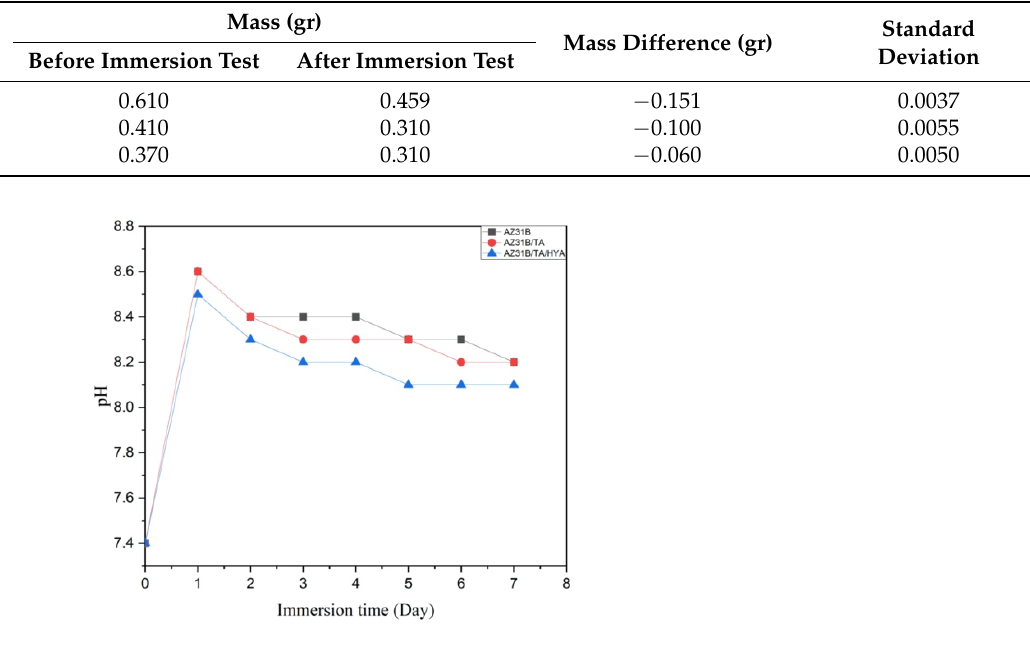
Figure 9. Changes in the pH of the solution in the immersion process of AZ31B, AZ31B/TA, and AZ31B/TA/HYA samples for seven days. AZ31B/TA/HYA samples for seven